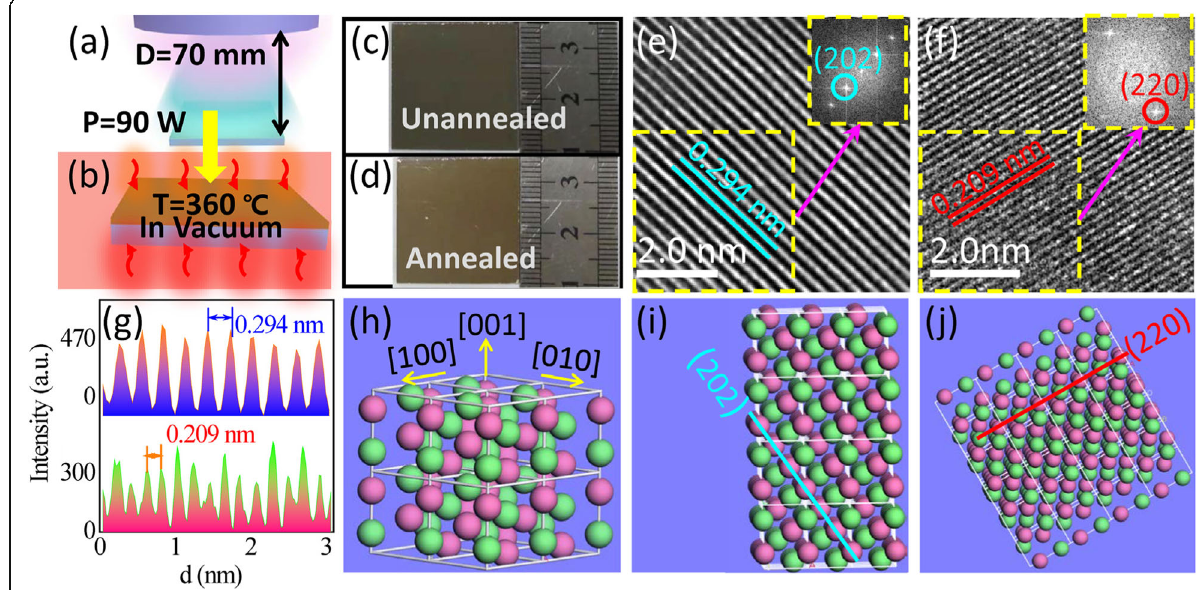
Fig. 1 a Magnetron sputtering of GeTe film on Si substrate. b Post-annealing of the GeTe film. c Optical images of as-deposited and d annealed GeTe films on quartz substrate. e – f TEM images and FFT patterns (inset) of the annealed GeTe film. g Line profiles of the lattice fringes of (202) and (220) crystal planes as shown in the top and bottom panels, respectively. h – j Schematic diagrams of the crystal